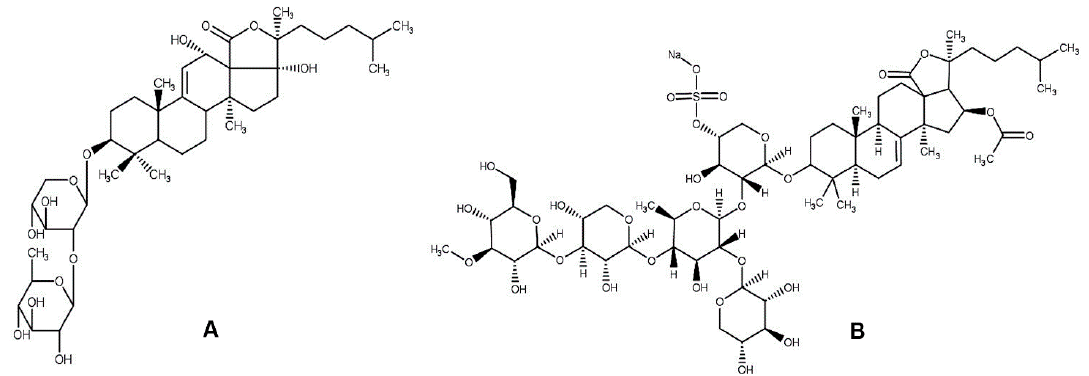
Figure 2. Chemical structure of DEB (desulfated echinoside B) ( A ) and FRA (frondoside A) ( B ).